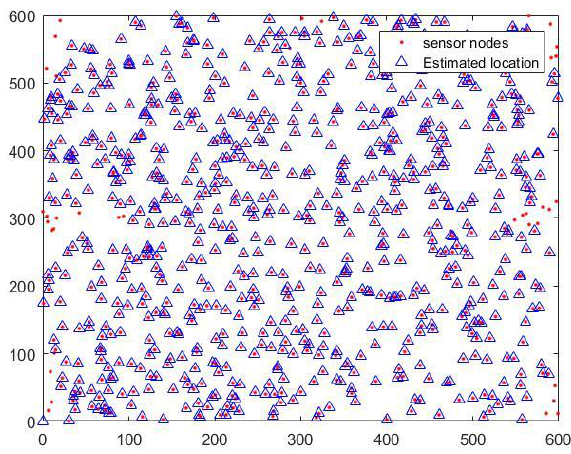
Figure 14. The location of the sensor node projected to the 2D plane.